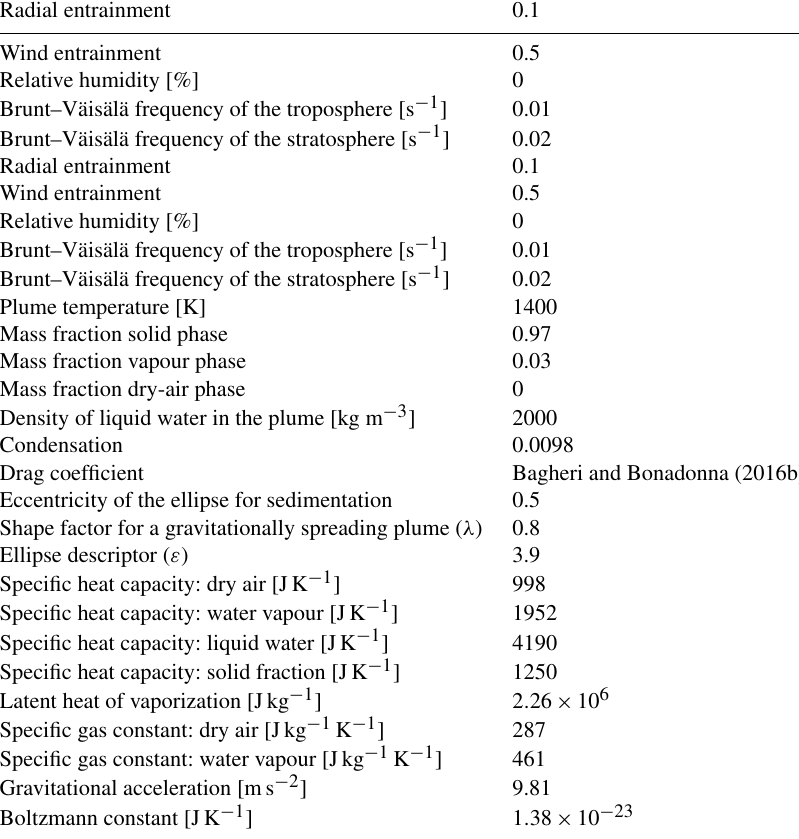
Table B1. Fixed model input